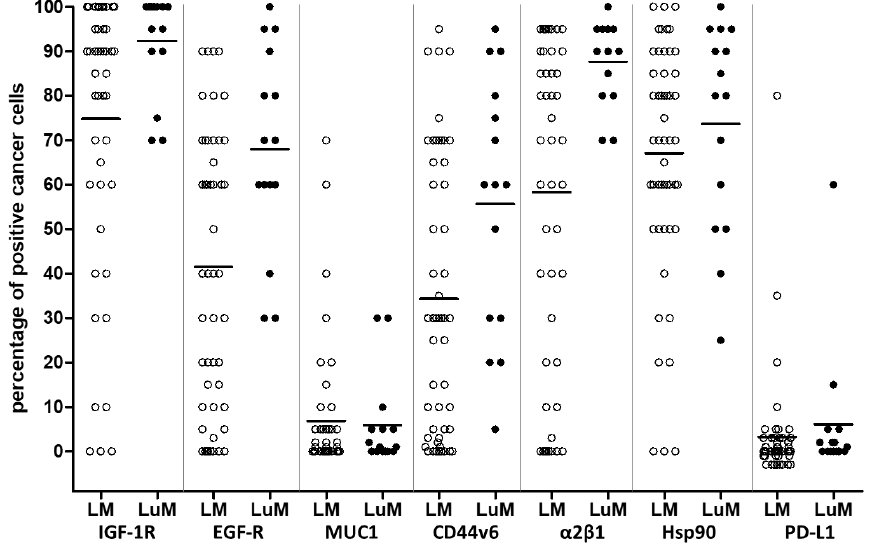
Figure 1. Biomarker Expression Pattern of Liver and Lung Metastases. horizontal bars, Means. Each dot represents a metastatic lesion; empty dots represent liver metastases ( LM ); filled dots represent lung metastases ( LuM ).